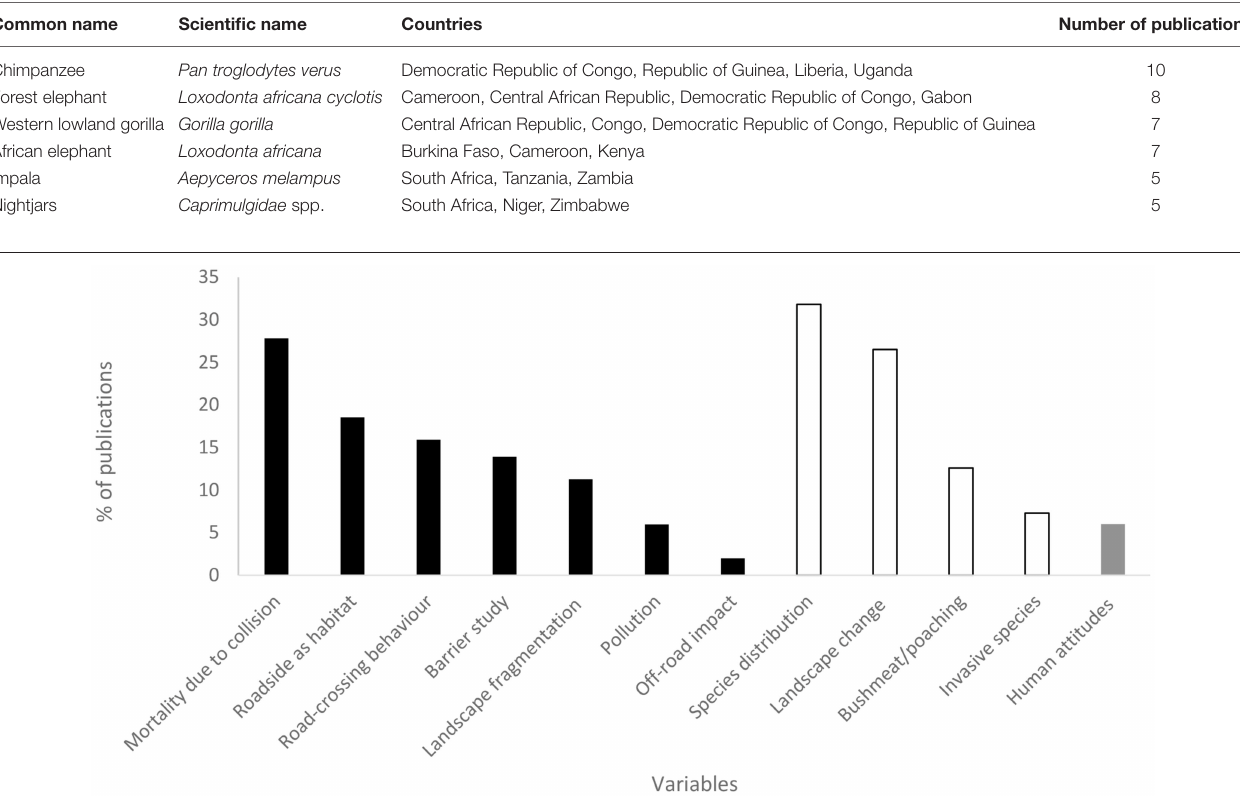
TABLE 2 | The species most commonly the focus of road ecology publications with five or more studies from the 210 reviewed publications for road ecology in Africa.